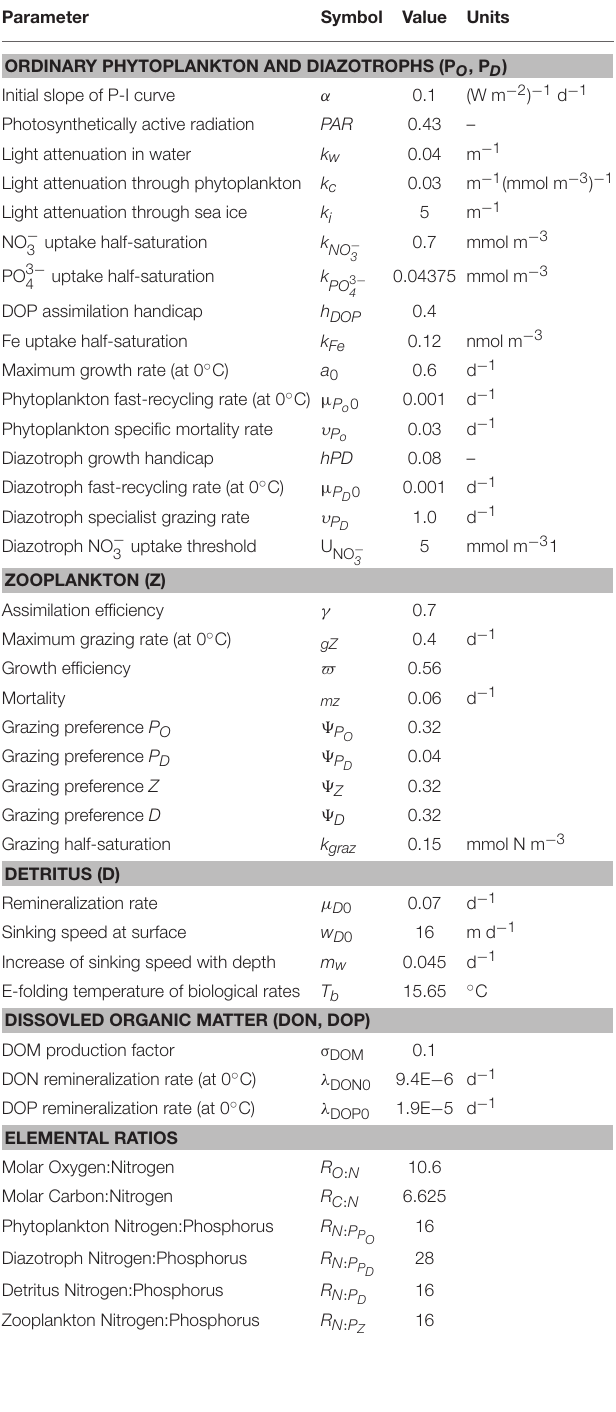
TABLE A1 | Marine Ecosystem-Biogeochemistry